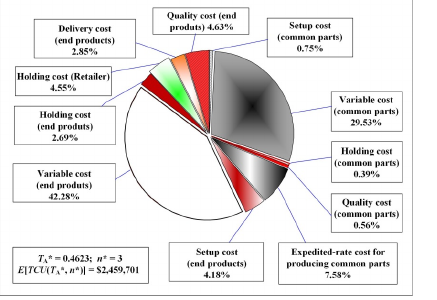
Fig. 9. The detailed cost contributors of E [ TCU ( T A *, n *)] Fig. 10. The detailed cost contributors to system quality cost in E [ TCU ( T A *, n *)]